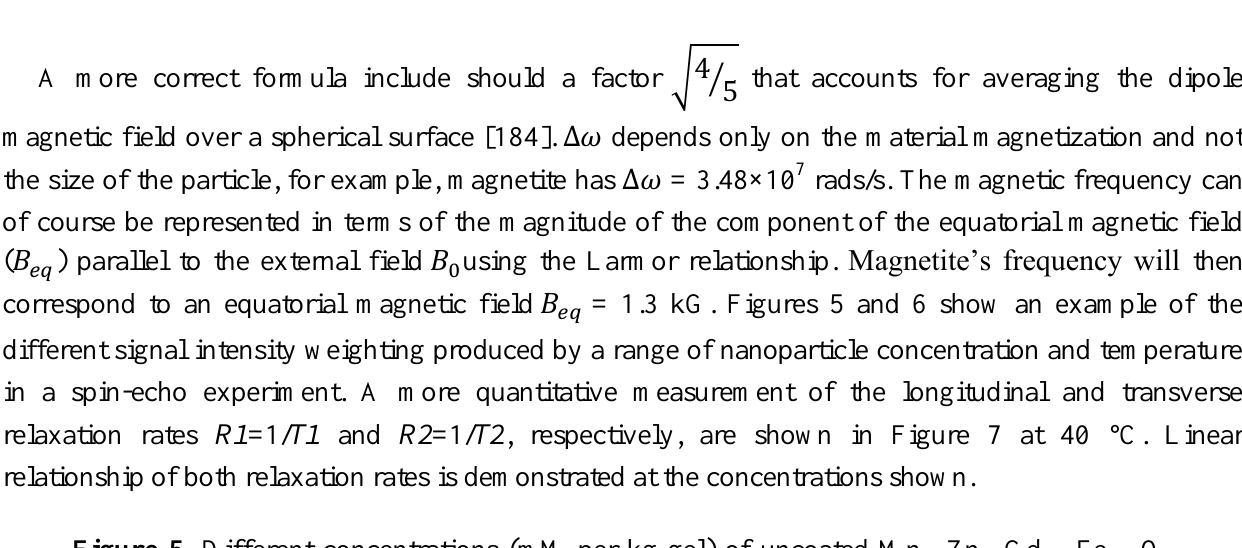
Figure 5. Different concentrations (mM per kg gel) of uncoated Mn